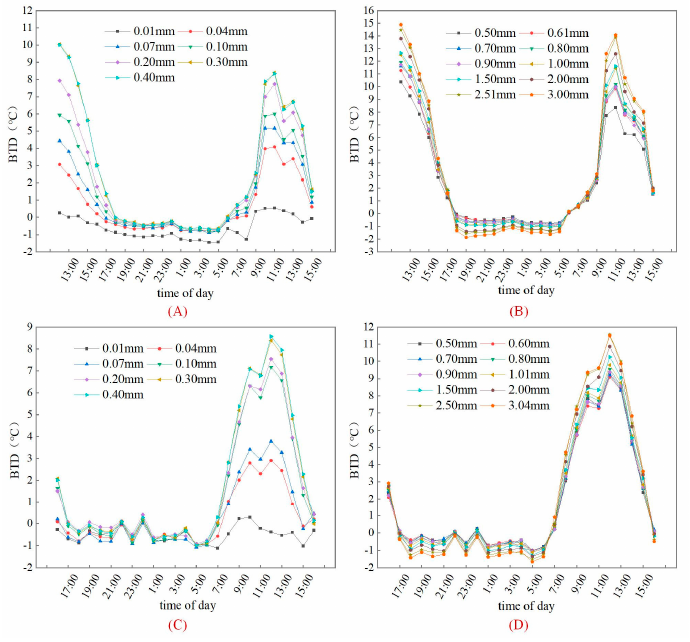
Figure 7. ( A ) Changes in brightness temperature difference of OFT (0.01 − 0.40 mm) in summer; ( B ) Change of BTD of OFT (0.50 − 3.00 mm) in summer; ( C ) Change of BTD of OFT (0.01 − 0.40 mm) in autumn; ( D ) Change of BTD of OFT (0.50 − 3.00 mm) in autumn.